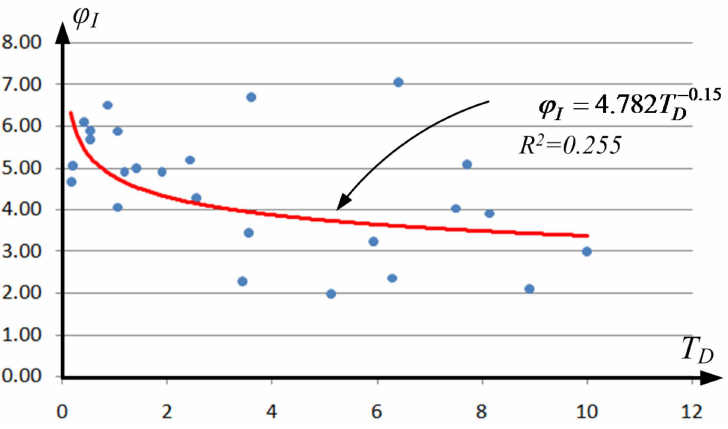
Figure 9. Individual resistance vs. down